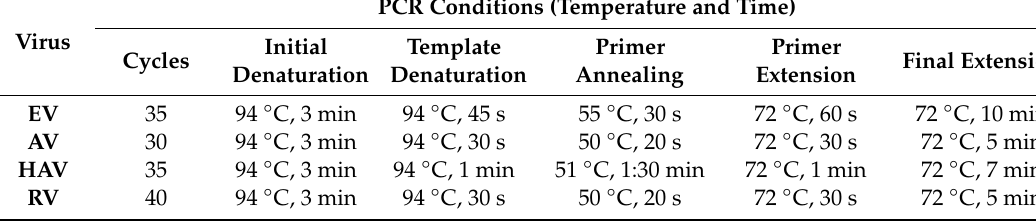
Table 2. PCR cycling